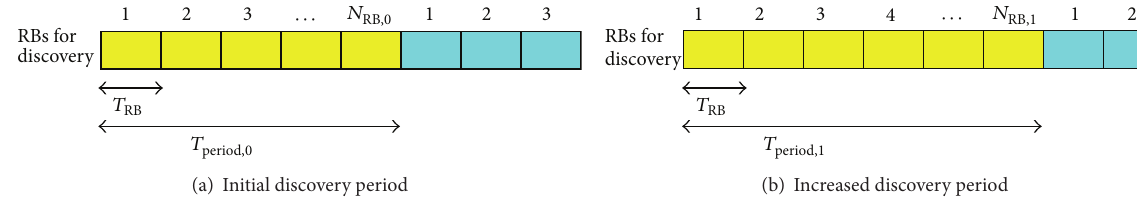
Figure 1: Resource for discovery message transmissions with different discovery periods.